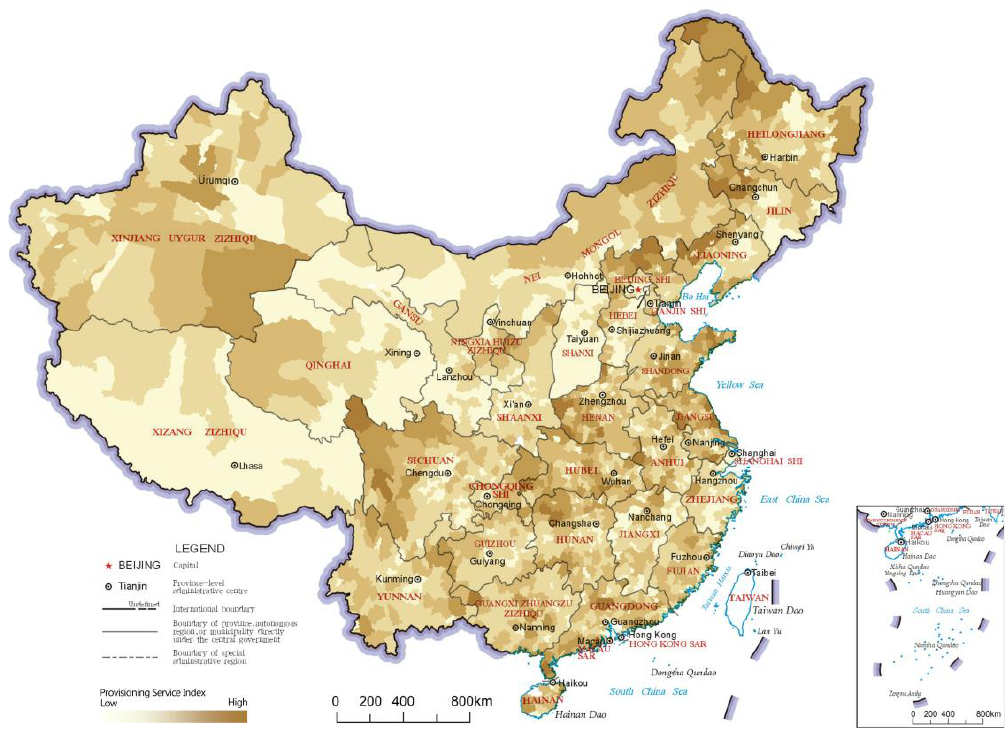
Figure 3. Distribution map of provisioning service indices of the county-level regions in China.